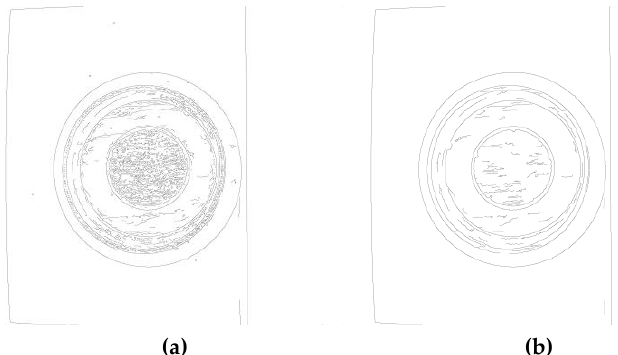
Figure 18. Edge detection. (a) Candidate edges by Canny detection. (b) Structural edges by filtering based on length and linearity features.